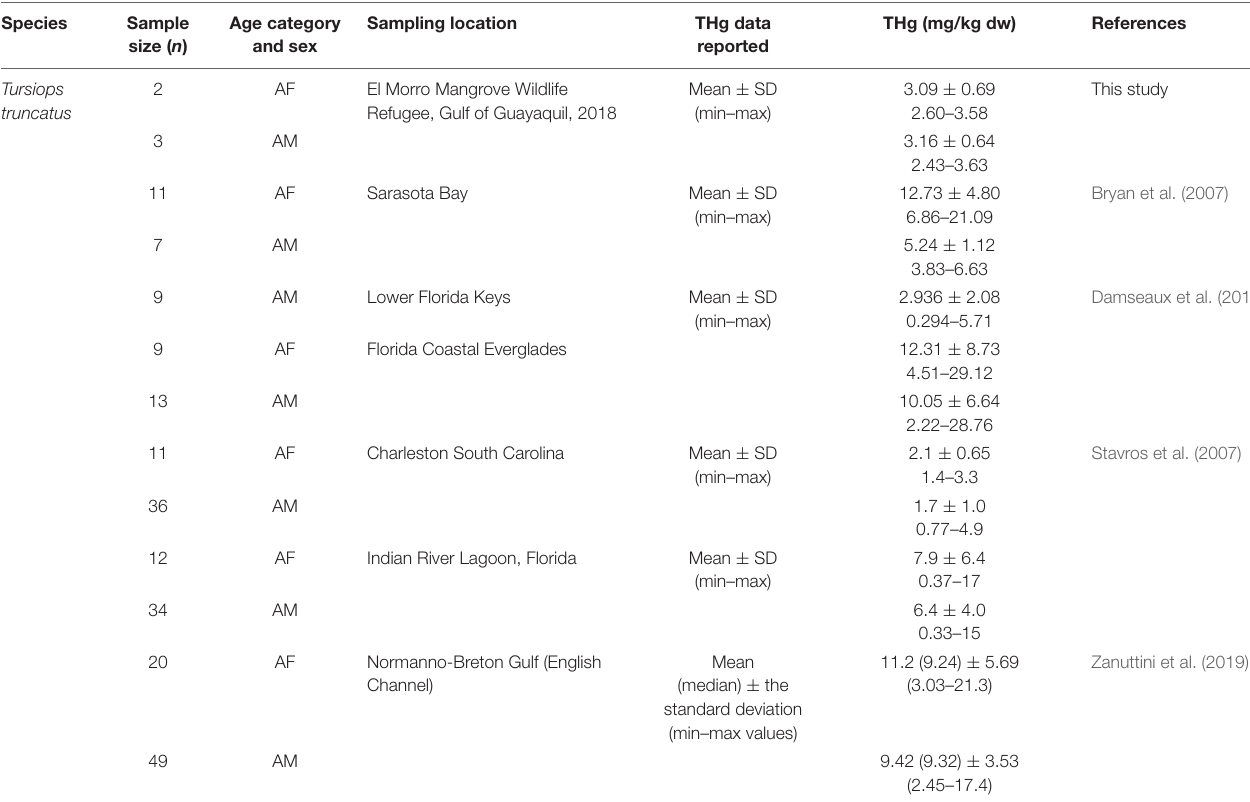
TABLE 4 | Geographical comparisons between of total mercury (THg) concentrations reported in this study and the data reported in the skin of bottlenose dolphins from the southeast coast of United States and dolphins from the English Channel. Species Sample size ( n